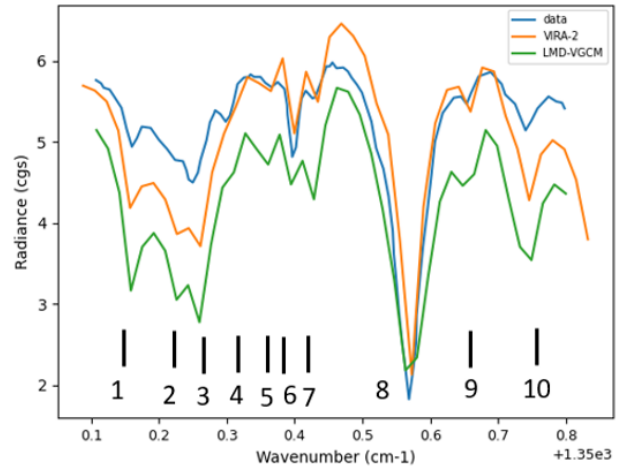
Figure 7. Comparison between simulations and TEXES data ([23]). Two simulations are com- pared to the data (blue). The VIRA-2 model (orange) has a higher radiance than the LMD-VGCM model (green) and weaker and narrower SO 2 lines compared with the LMD-VGCM model. The uncertainty of the datapoints of the observations is approximately 5%. The error of the simula- tions is approximately 0.1%. The absorption lines were numbered and can be consulted in Table 1.